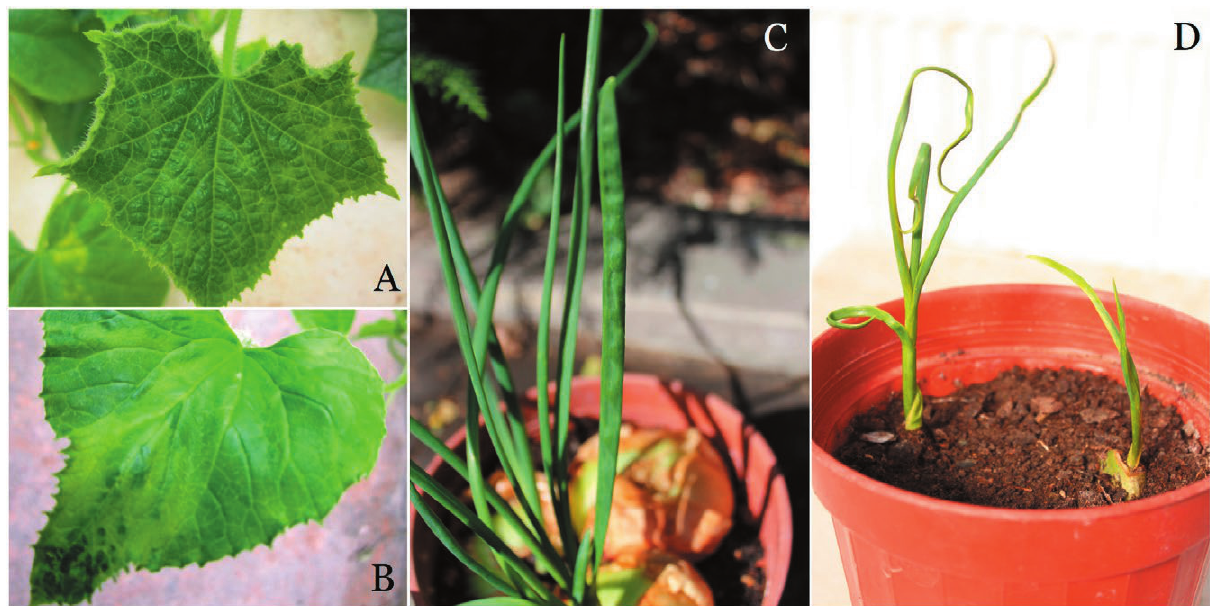
Figure 2. Symptoms on plants mechanically inoculated with two CMV isolates from onion. A. Mosaic on cucumber inoculated with CMV- 14.3Po, B. Mosaic and mottle on melon inoculated with CMV-14.3Po, C. Mild leaf malformation on onion inoculated with CMV-15.5Po, D. Severe leaf malformation and stunting on garlic inoculated with